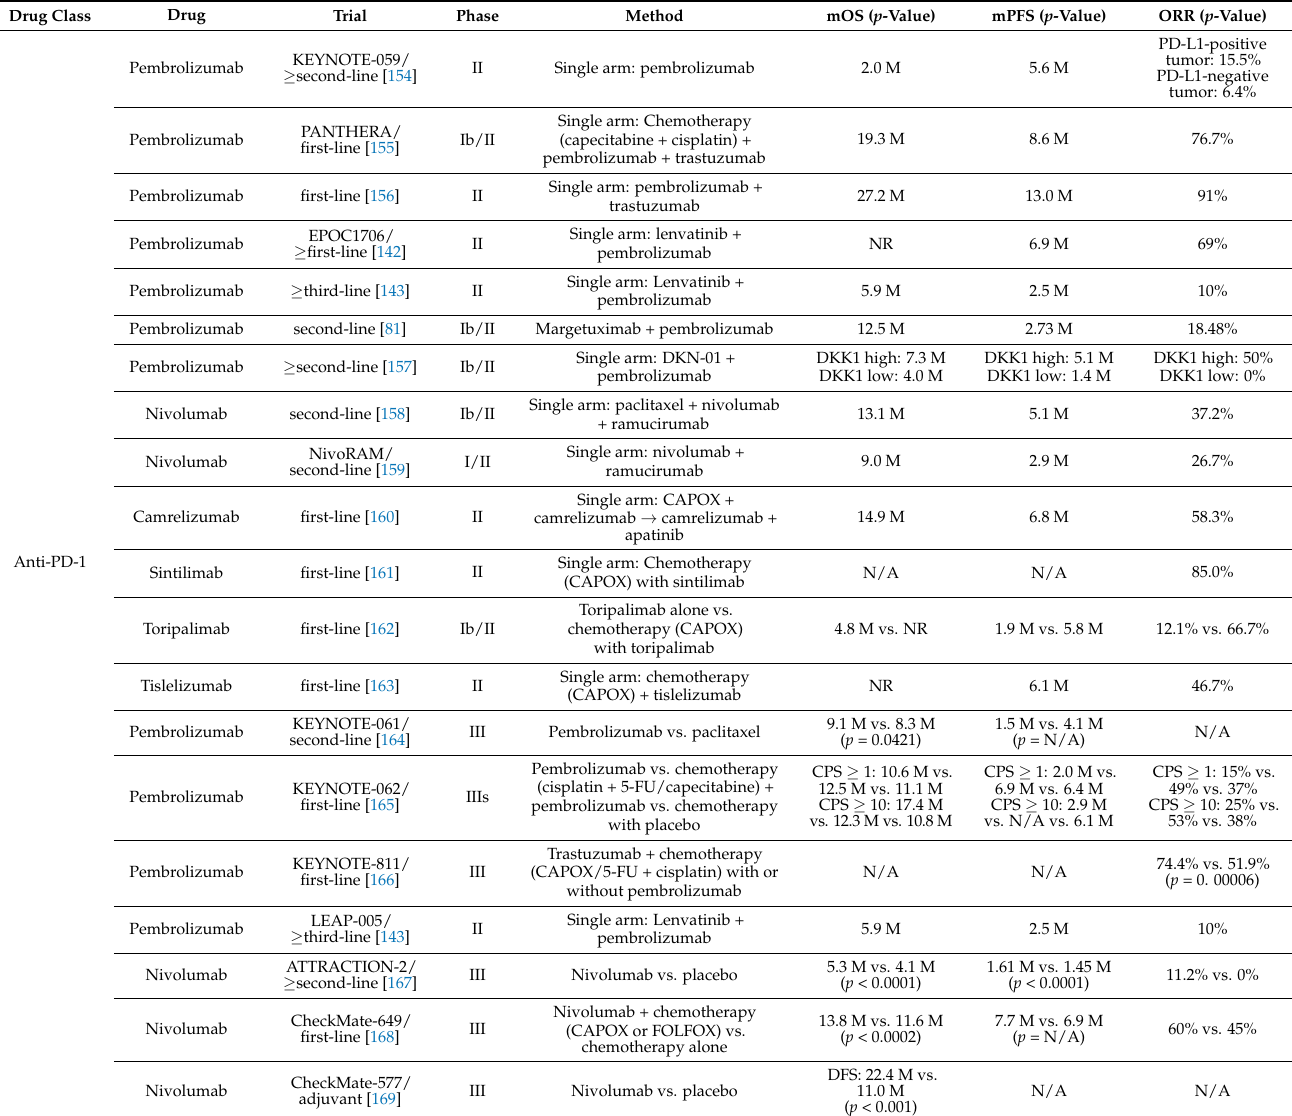
Table 4. Phase II and III trials of immune checkpoint inhibitors for gastric cancer. mOS, median overall survival; mPFS, median progression-free survival; HR, hazard ratio; M, months; ORR, objec- tive response rate; 5-FU, 5-fluorouracil; FOLFOX, folinic acid, fluorouracil, oxaliplatin, oxaliplatin; FOLFIRI, folinic acid, fluorouracil, irinotecan; N/A, not available; TKI, tyrosine kinase inhibitor; PD-1, programmed cell death protein-1; PD-L1, programmed cell death ligand 1; CTLA-4, cytotoxic T lymphocyte protein 4; DKK1, Dickkopf-1; CPS, combined positive